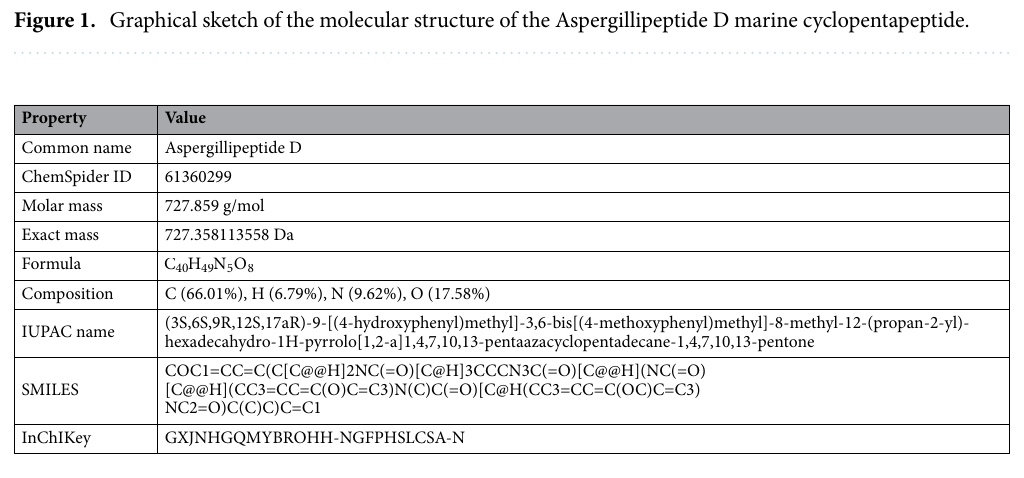
Table 1. Names, identifiers and basic properties of the Aspergillipeptide D marine cyclopentapeptide.